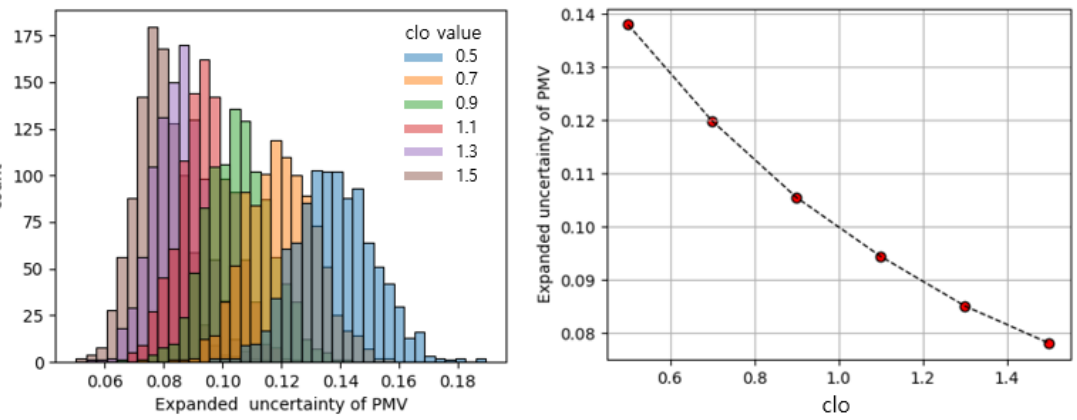
Figure 15. Propagation of uncertainty in PMV by clo value.